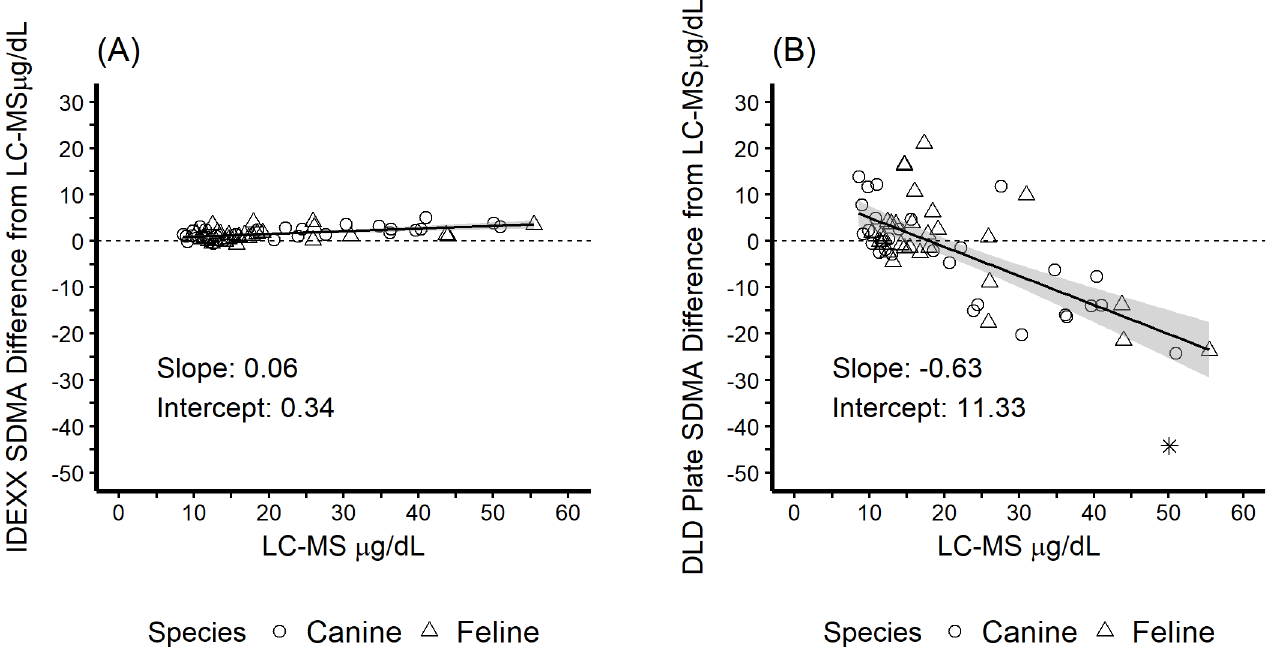
Fig 2. Bias of two SDMA diagnostic methods–difference from the reference standard (LC-MS). (A) The IDEXX SDMA Test. (B) The DLD SDMA ELISA method. Solid line represents best fit linear model; shading represents 95% confidence interval around the line. Dashed line is the line of equality. Outliers are represented by �